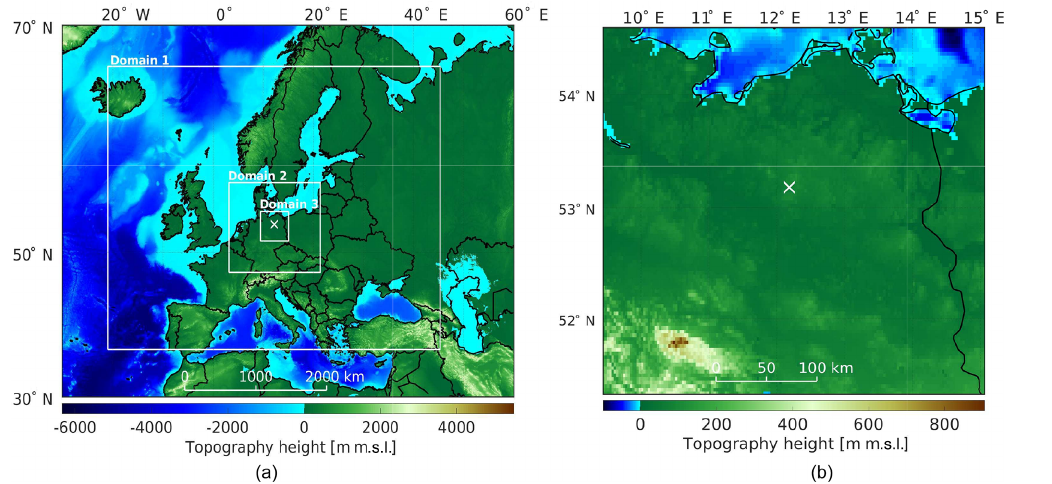
Figure 1. Topography map of all three WRF model domains (a) and a magnification of the innermost domain (b) with the lidar measurement site highlighted by a white